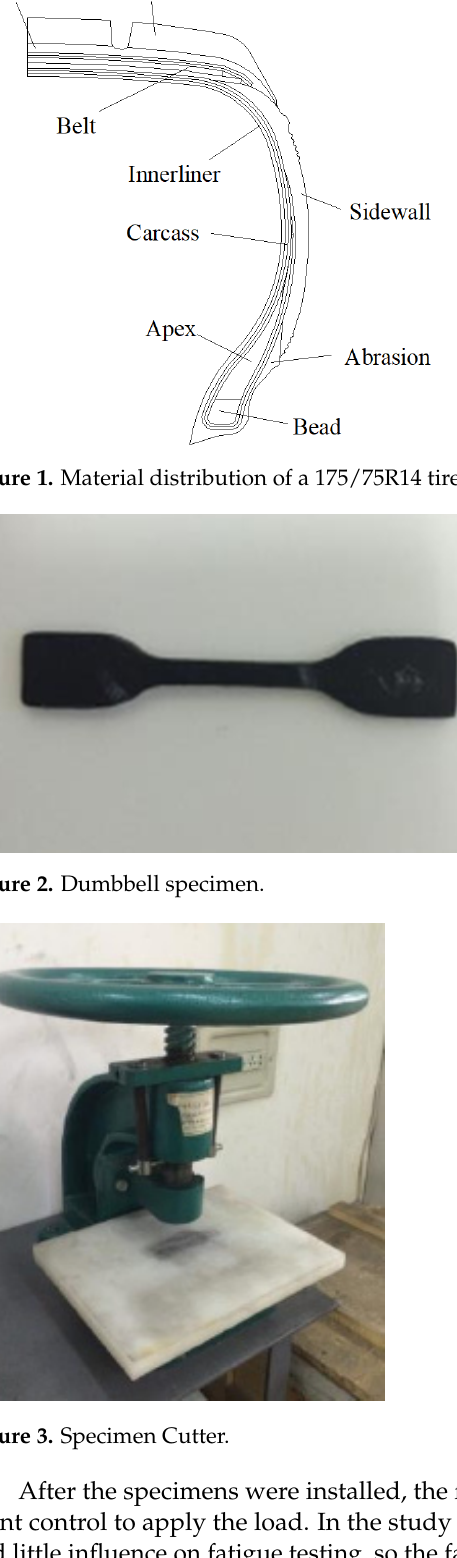
Figure 1. Material distribution of a 175/75R14 tire.